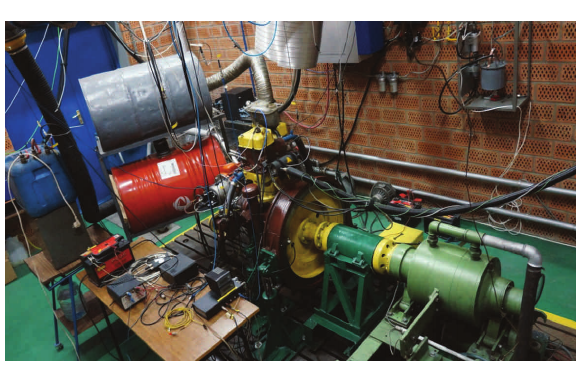
Fig. 4. SB-3.1 single-cylinder experimental engine equipped with CR-type fuel system